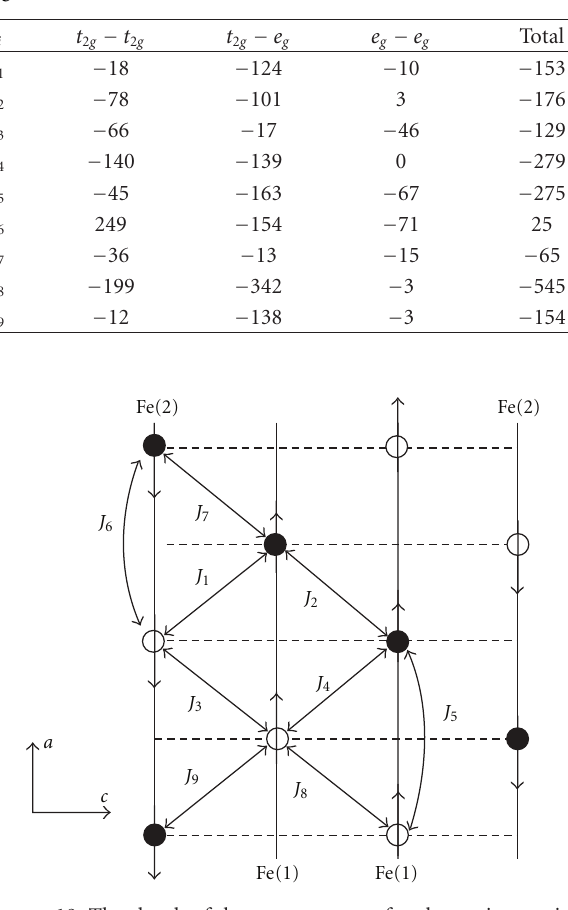
Figure 19: The sketch of the arrangement of exchange interaction parameters within the ribbon of iron atoms. Open circles corre- spond to Fe 3+ , while Fe 2+ cations are noted by the closed circles. The spin moment direction on each Fe site is shown by an arrow.